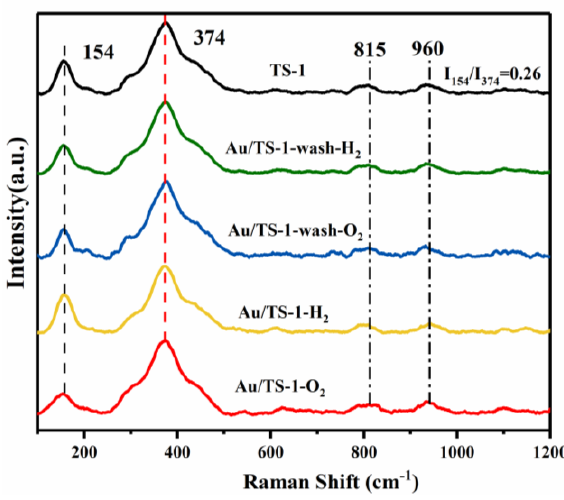
Figure 4. Raman spectra of TS-1 support and Au/TS-1 catalysts.